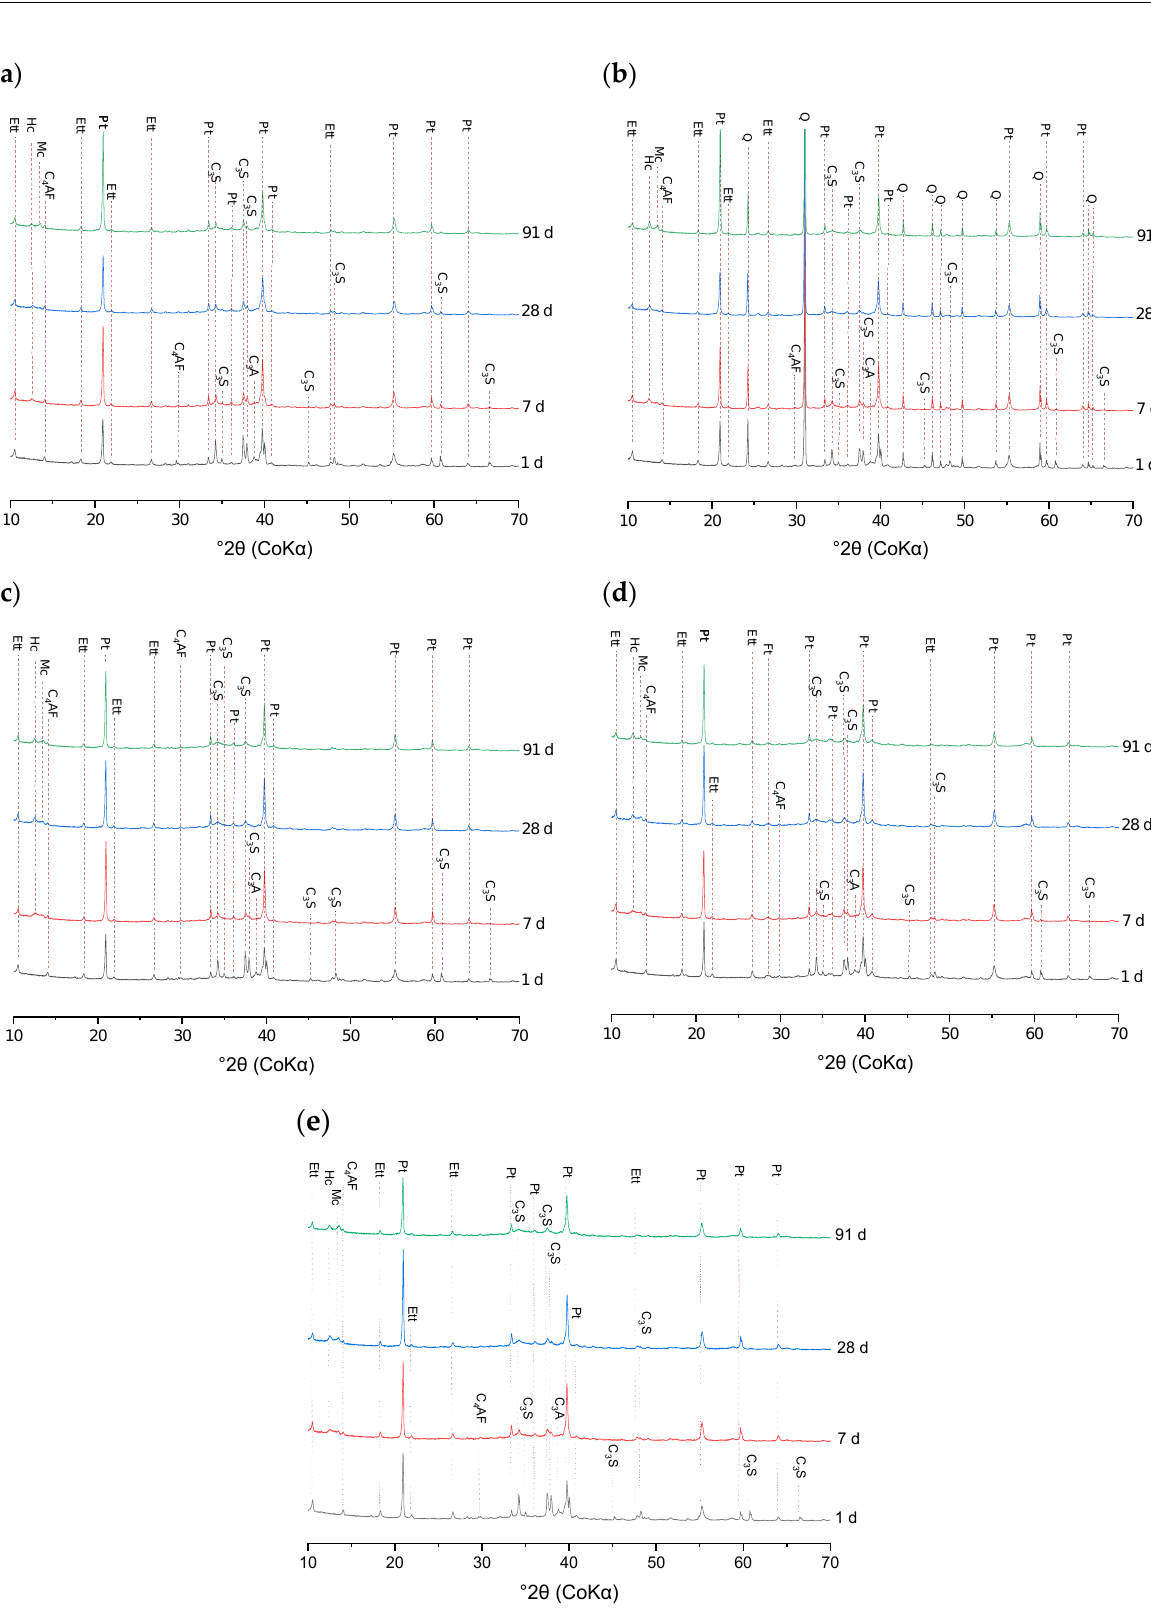
( d ) ( e ) Figure 6. Area charts displaying the evolution of different phases over time; values in g/100 g of binder. ( a ) P_PC, ( b ) P_QP, ( c ) P_TS1, ( d ) P_TS2 and ( e ) P_TS3.